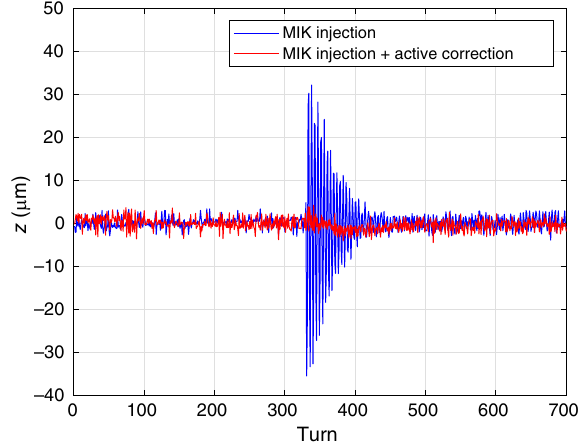
FIG. 16. Variations of the vertical position of the stored beam due to a single triggering of the MIK, when the active correction is off (blue) and on (red). This figure illustrates two processed KALYPSO images.